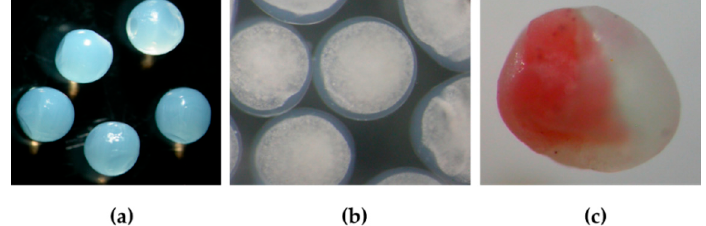
Figure 2. Structures of calcium alginate microparticles: ( a ) microspheres, ( b ) microcapsules W / O / W emulsion in core surrounded by calcium alginate shell, and ( c ) “Janus particle” (the particles were prepared by a Büchi B-390 Microencapsulator).